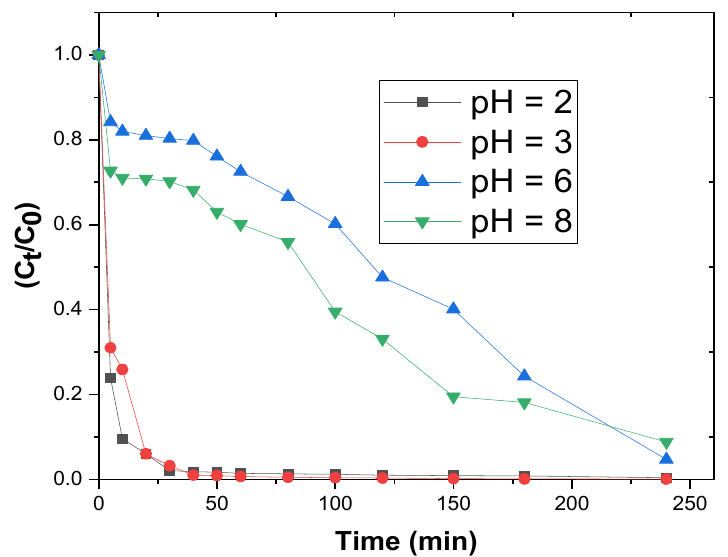
Figure 6. Effect of pH on the degradation of indigo carmine in aqueous